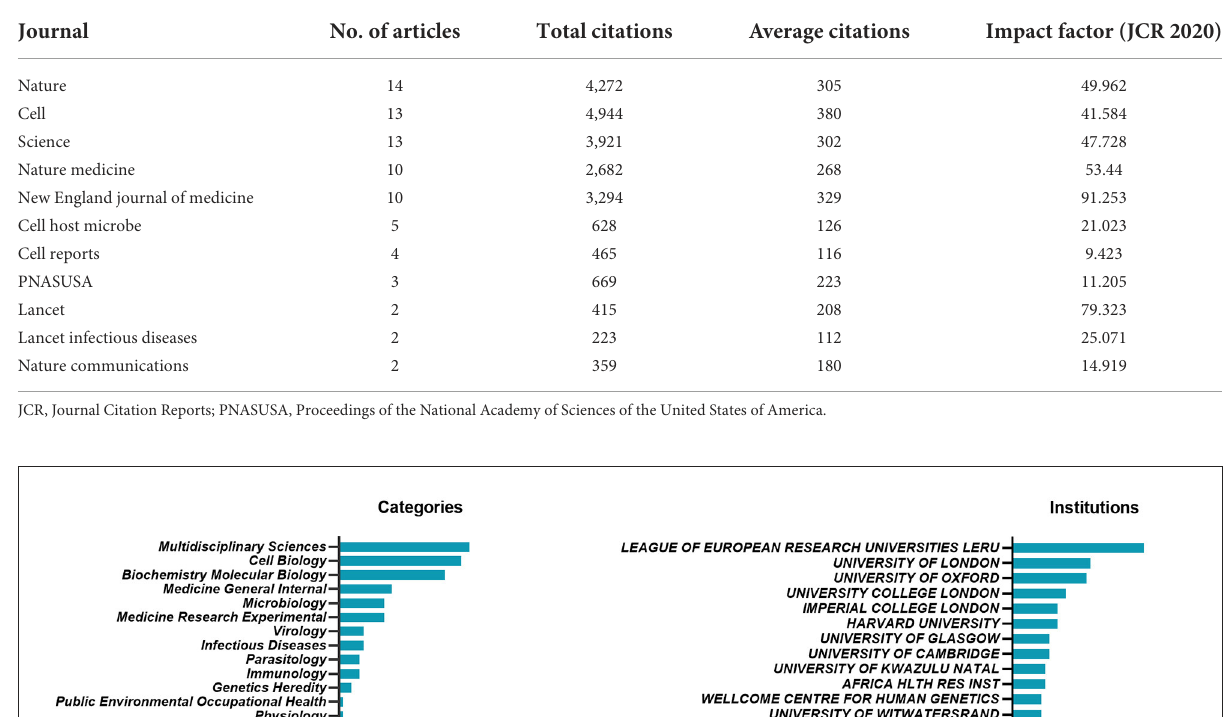
TABLE 2 Journals in which two or more of the 100 most-cited SARS-CoV-2 variant articles were published.